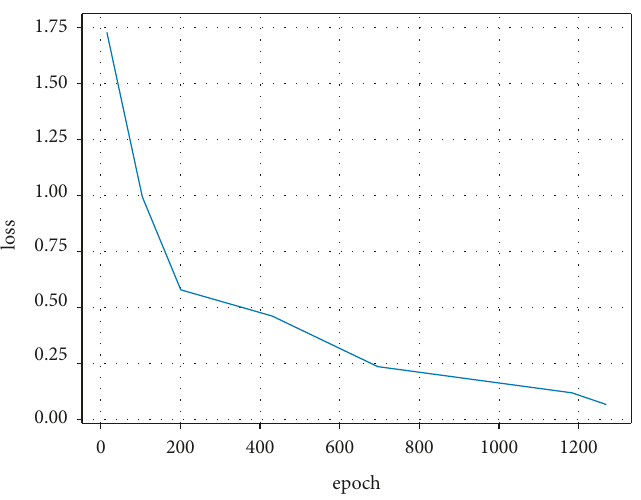
Figure 11: Variation of mean squared